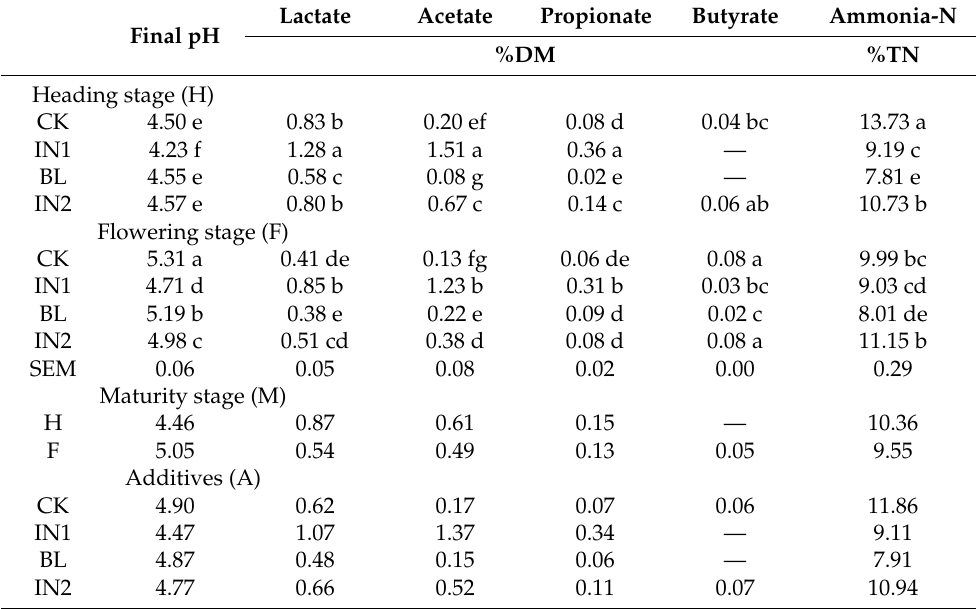
Table 4. Fermentation parameters of perennial oat silages treated without (CK) or with local LAB inoculant (IN1), commercial LAB inoculant (IN2), and sodium benzoate